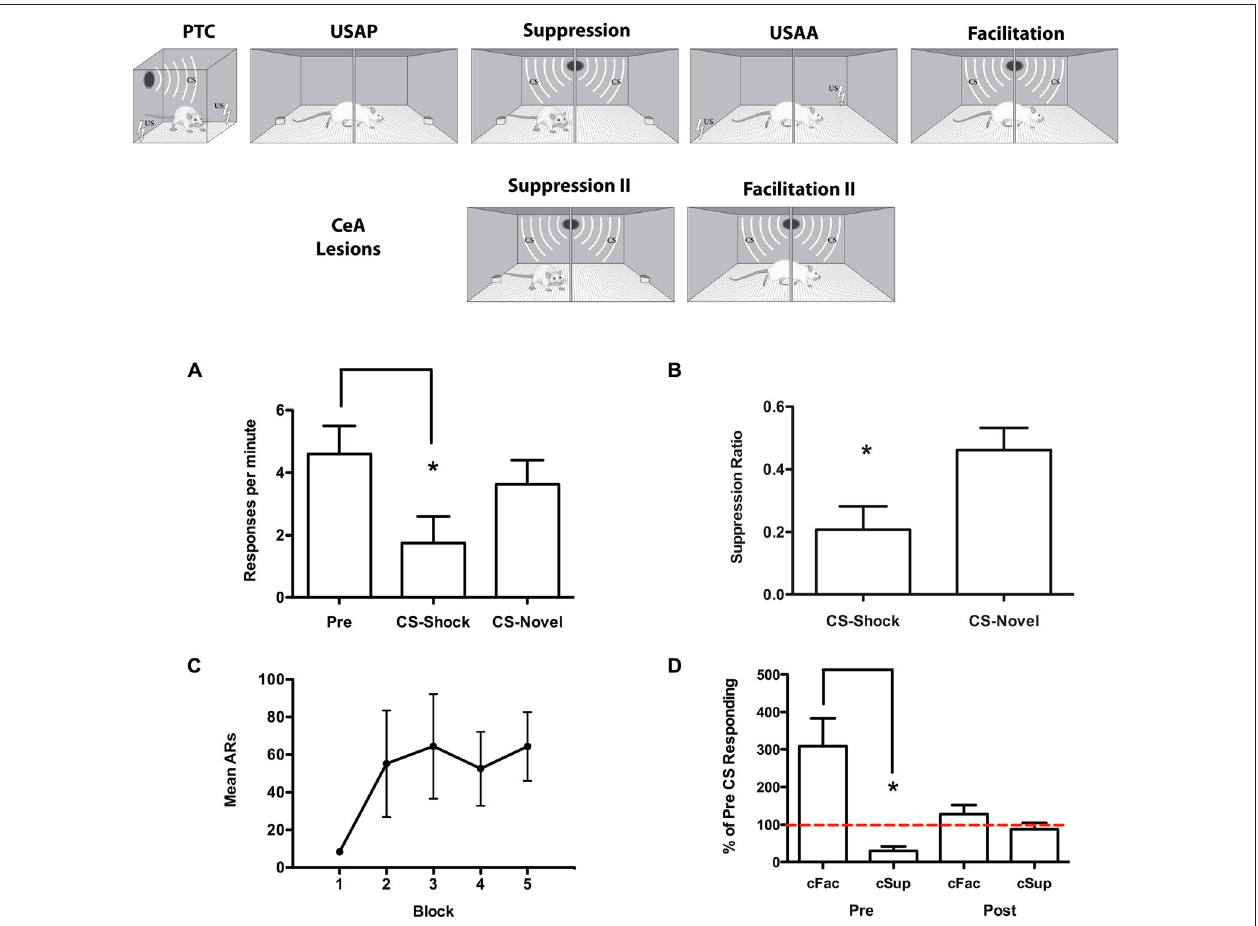
FIGURE 3 | Upper section: Experimental design for the modulatory task used in Experiment 2. The Pavlovian threat conditioning (PTC) session took place on the first day of training. Subjects underwent the suppression (cSup) and then facilitation (cFac) components. USAP refers to unsignaled approach training and unsignaled sidman active avoidance (USAA) to USAA training phases where the two-way shuttle response was acquired in reward vs. avoidance procedures. After recovery from CeA lesions, additional tests were conducted. Lower section: Data collected for Experiment 2. Suppression test data are presented in (A) in terms of responses per minute during the Pre CS and CS periods and (B) in terms of the suppression ratio ( CSresponding/CSresponding + PreCSresponding ). USAA training data are presented in (C) for each three-session block in terms of mean avoidance responses per block. Data from the pre-surgical tests for conditioned facilitation and conditioned suppression are presented on the left of (D) and the post surgical tests on the right side. These data are presented in terms of percent of Pre CS responding for each test. ∗ p <